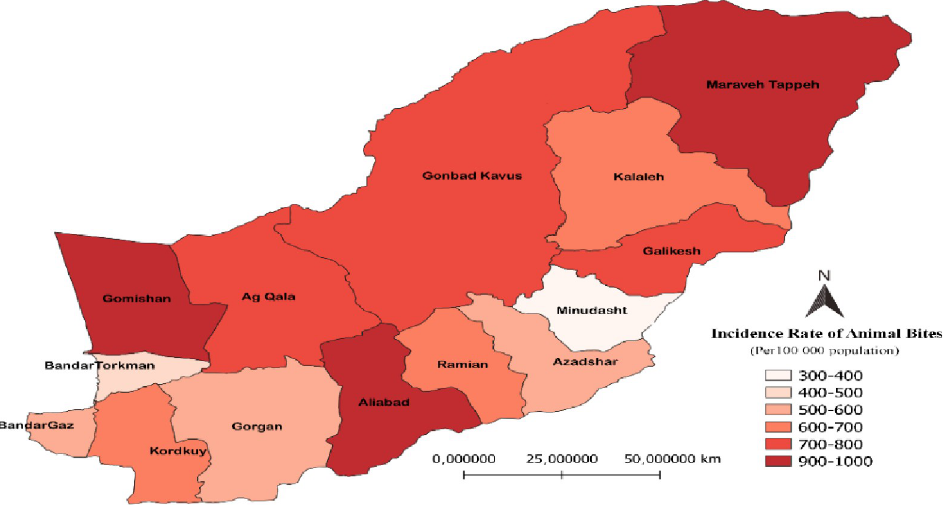
Fig 2. Animal bite incidence rates in Golestan counties